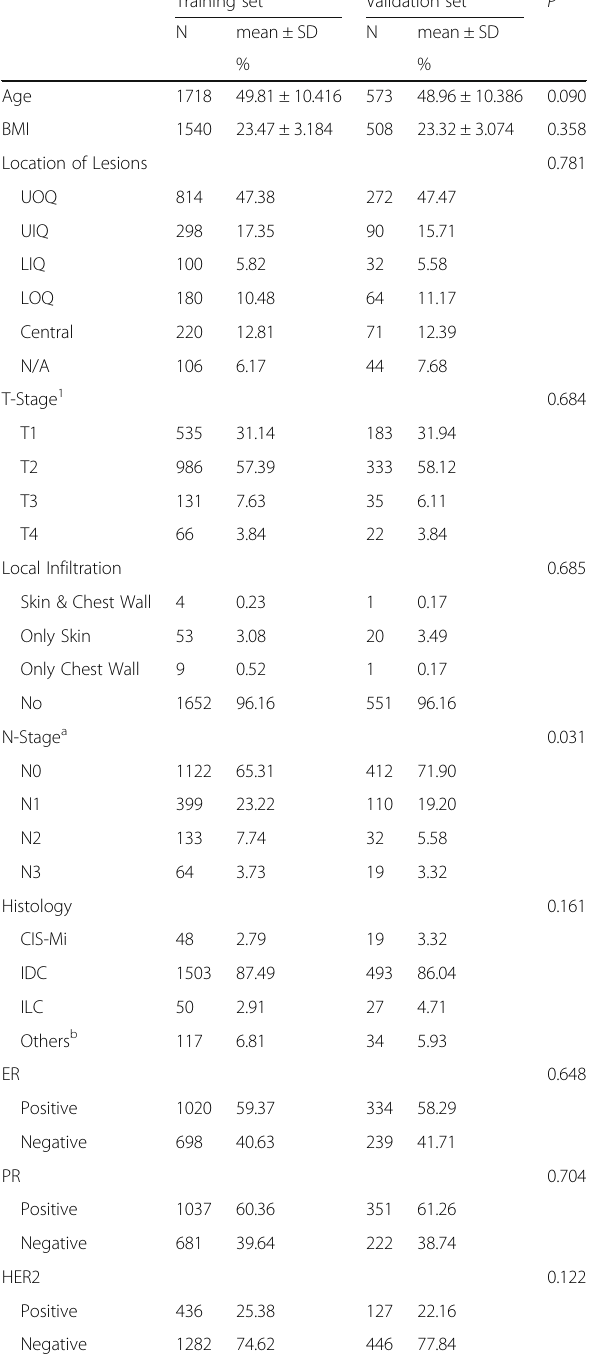
Table 1 Clinicopathological characteristics of the study populations Training set Validation